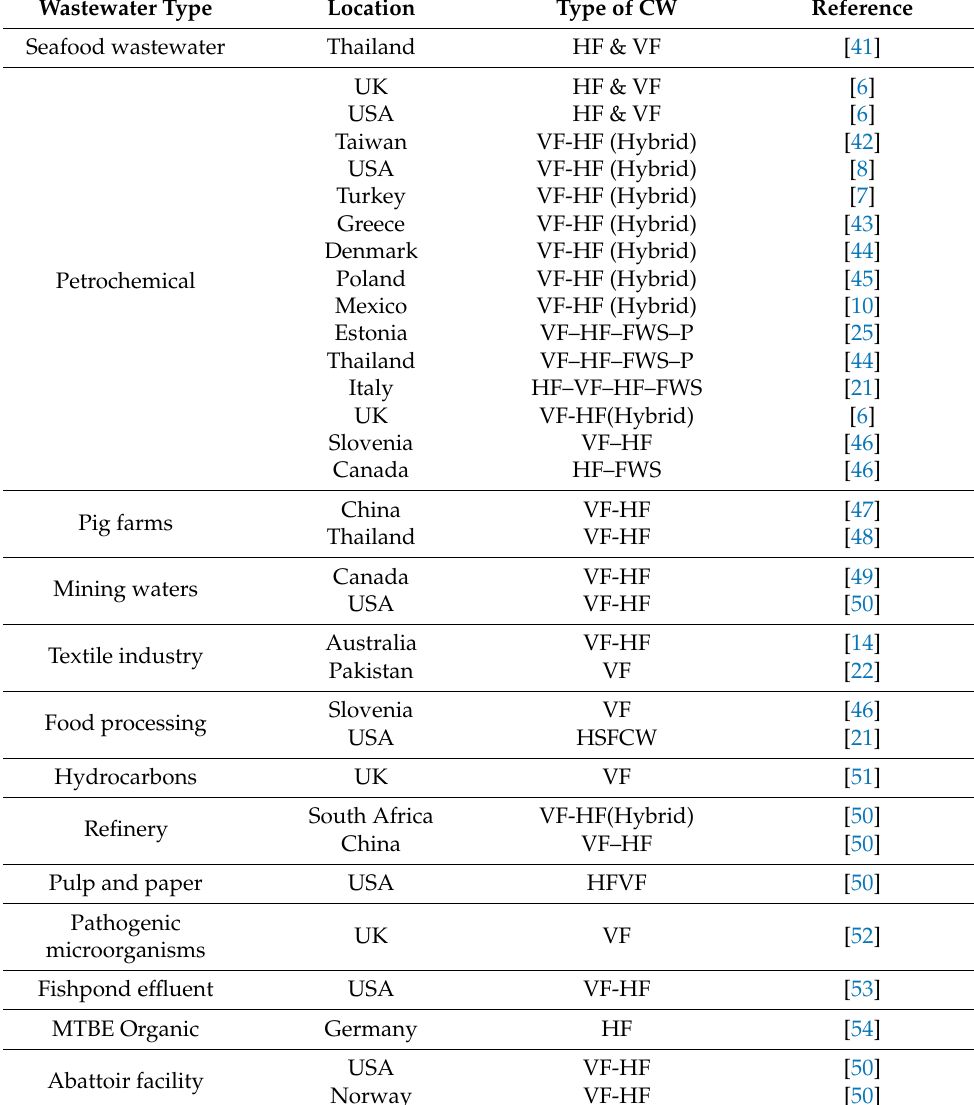
Table 1. Different applications of CW in Wastewater